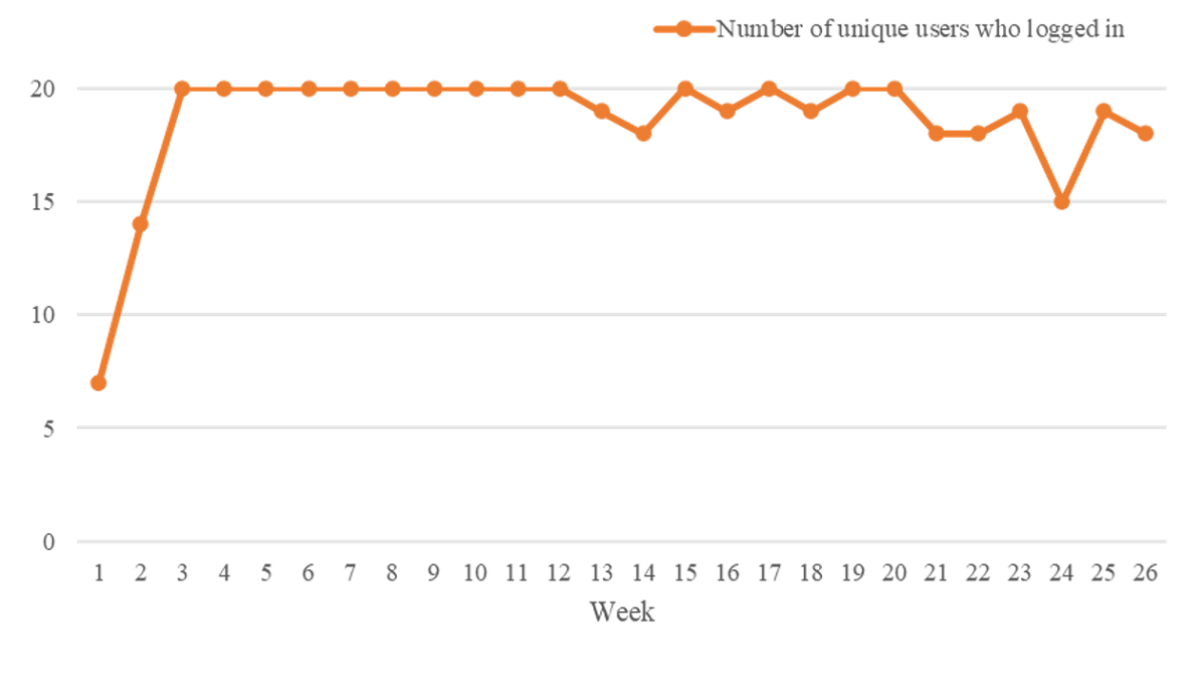
Figure 3. Number of unique participants who log in to the CAREs app at least once each